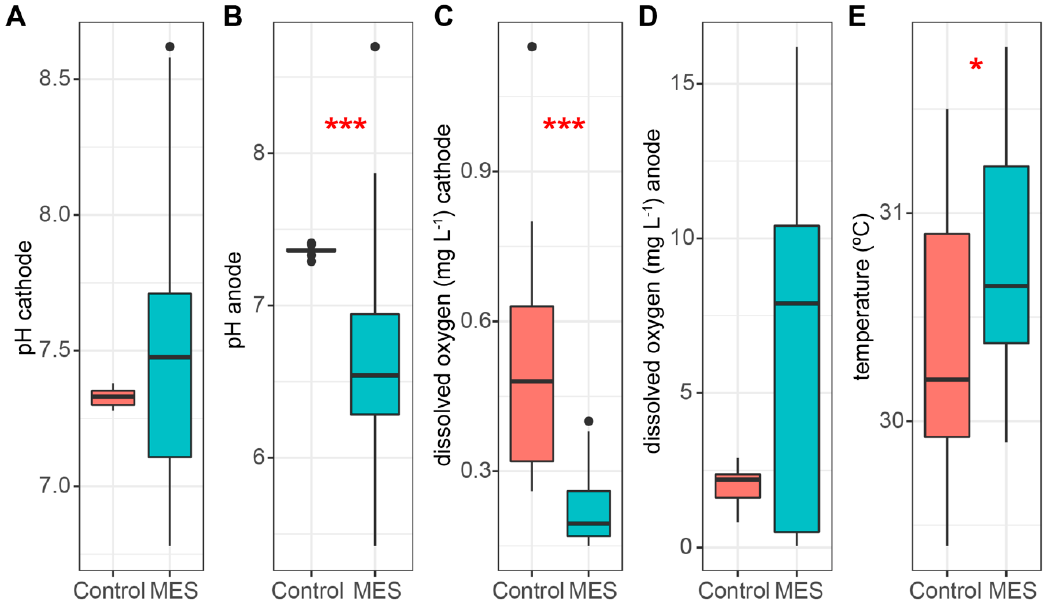
Figure 5. pH in the cathode chamber ( A ), pH in the anode chamber ( B ), dissolved oxygen concentration in the cathode chamber ( C ), dissolved oxygen concentration in the anode chamber ( D ), and temperature in the cathode chamber ( E ). Median, min / max, 25% and 75% quartile values are presented. The asterisks denote statistically significant di ff erences between the MES and control reactors * p < 0.05; *** p < 0.001.